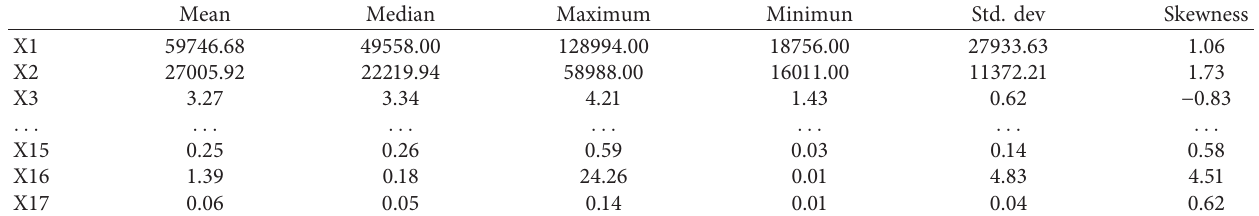
Table 3: Statistical data characteristics.